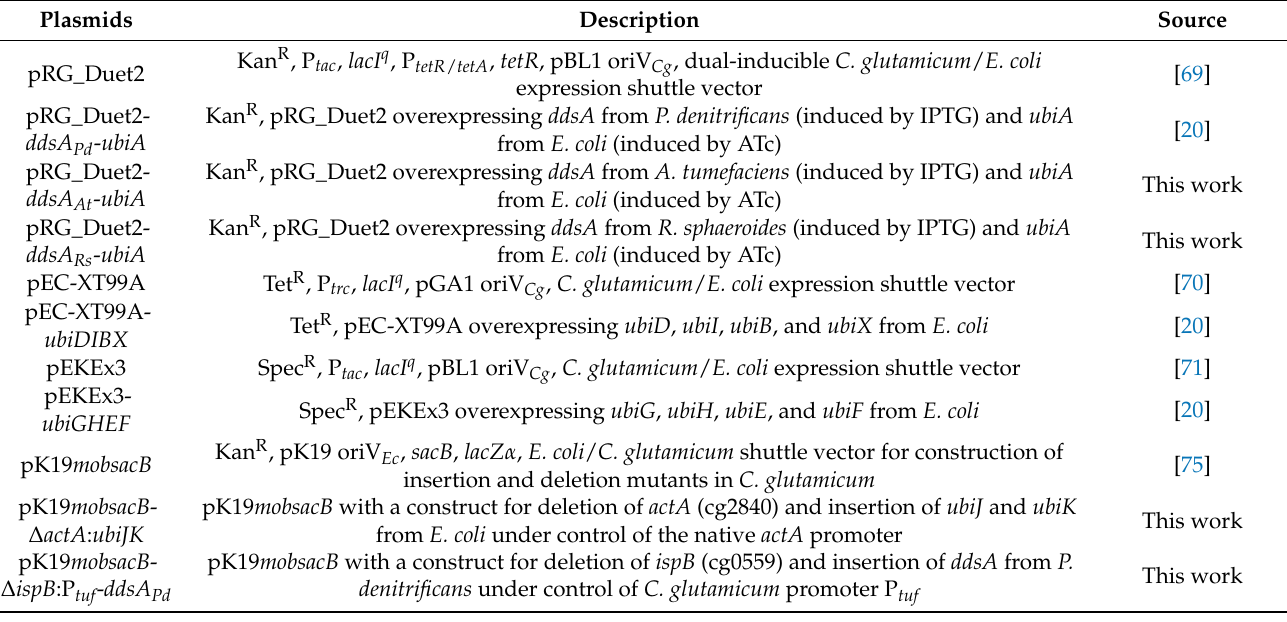
Table 5. Plasmids used in this study.